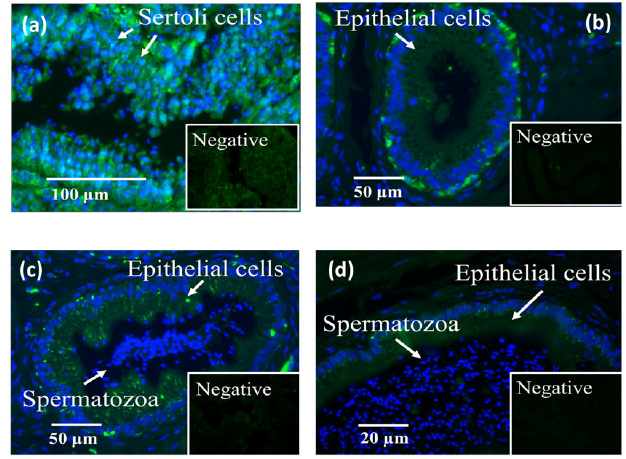
Figure 3. Localization of LGALS3BP using immunofluorescence (FITC; insets are negative controls) and nuclear chromatin counterstaining (Hoechst) in cross sections of ( a ) seminiferous tubules, ( b ) caput, ( c ) corpus, and ( d ) cauda of the epididymis (n = 5 males).